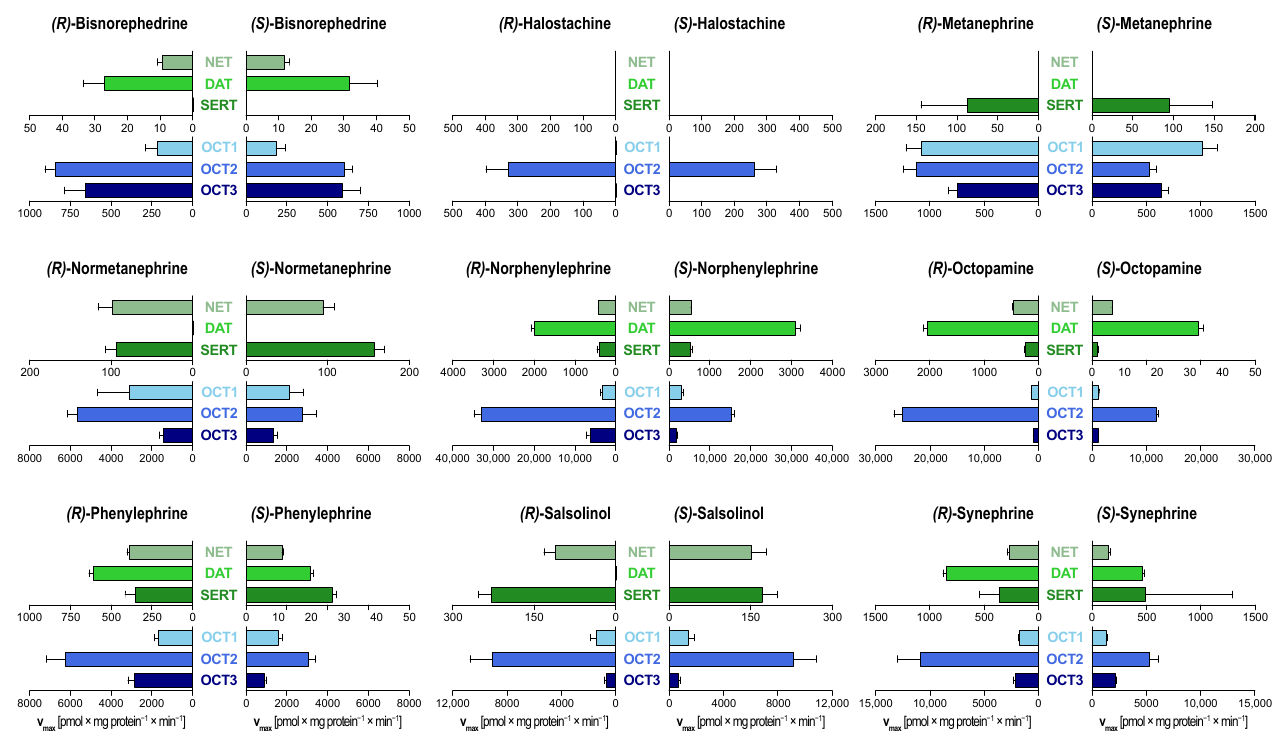
Figure 3. Maximum transport capacities, v max , of the investigated structural analogues of norepinephrine and epinephrine by MATs and OCTs. Data is presented as mean ± SEM of at least three independent experiments. Missing bars indicate no saturable net uptake by the respective